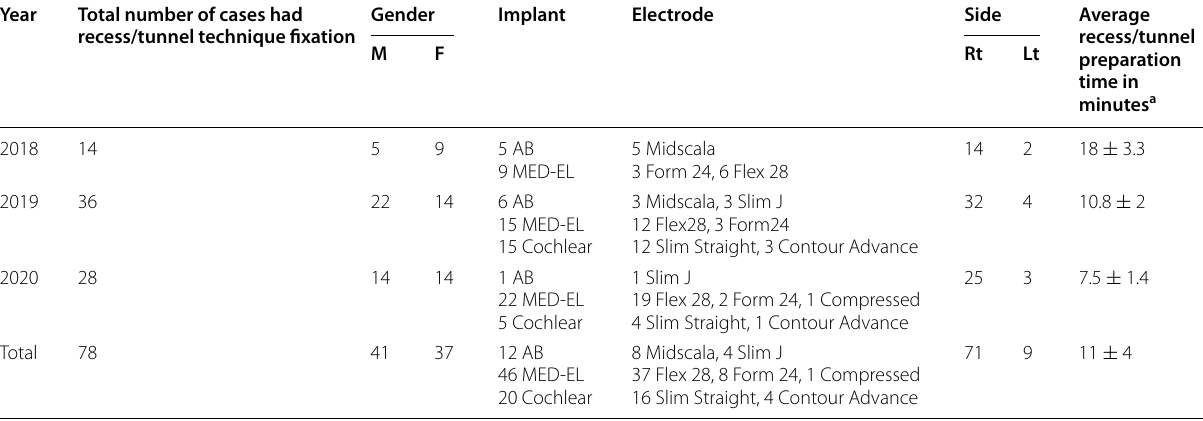
a Note the decrease in the average recess/tunnel preparation time over the years